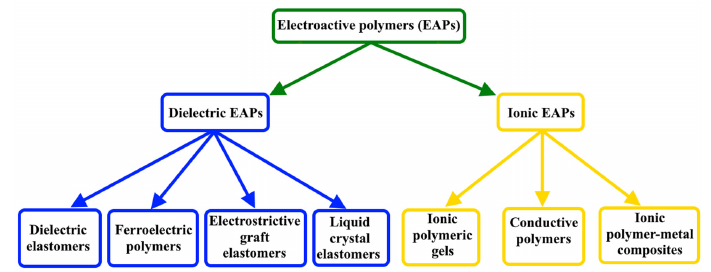
Figure 2. Electroactive polymers groups.